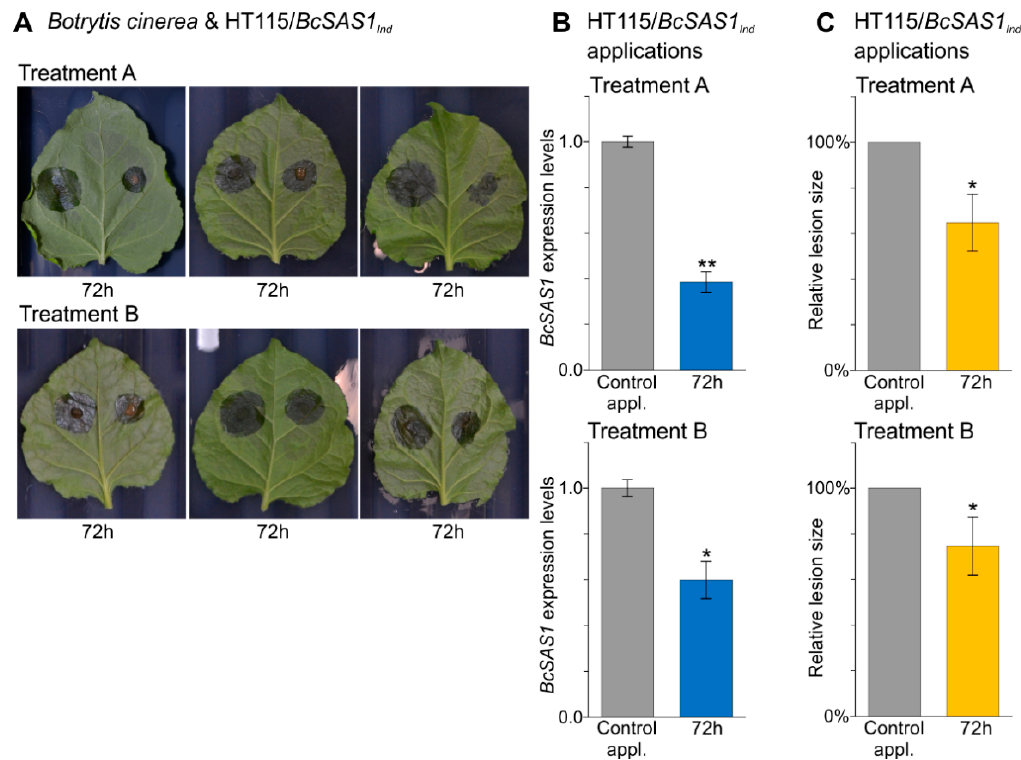
Figure 5. The HT115/ BcSAS1 Ind strain induces RNAi in B. cinerea and a reduction in fungal growth under in vivo conditions. ( A ) B. cinerea inoculations on N. benthamiana leaves. Spores of the fungus were spot inoculated on leaves of N. benthamiana and 6 h later, 10 μ L of the living bacteria or the whole-cell autolysates, obtained from the OD 600 1.0 culture, were applied to the same inoculation spots. All measurements were taken 72 h later. ( B , C ) BcSAS1 expression levels (Panel B) and the relative infection lesion size produced by B. cinerea in vivo on leaves of N. benthamiana (Panel C), following its exposure to living (Treatment A) or lysed (Treatment B) E. coli HT115(DE3) bacteria producing dsRNAs against BcSAS1 (HT115/ BcSAS1 Ind ; test application) or eGFP (HT115/ eGFP Ind ; control application). In Panels B and C, BcSAS1 expression levels and the mean relative lesion size of the infection areas in the test applications (blue bars and yellow bars, respec- tively) are relative to the control ones (grey bars, set to 1.0 and 100%, respectively). Error bars indicate standard deviations (SD) obtained from at least three biological replicates. Significant differences in gene expression between control and test applications were determined by a one-way ANOVA followed by Tukey’s HSD test, whereas significant differences in the mean relative lesion size were determined by one-sample t -test. Levels of significance are indicated above the bars by underlined star symbols (i.e., * p < 0.05, ** p < 0.01).